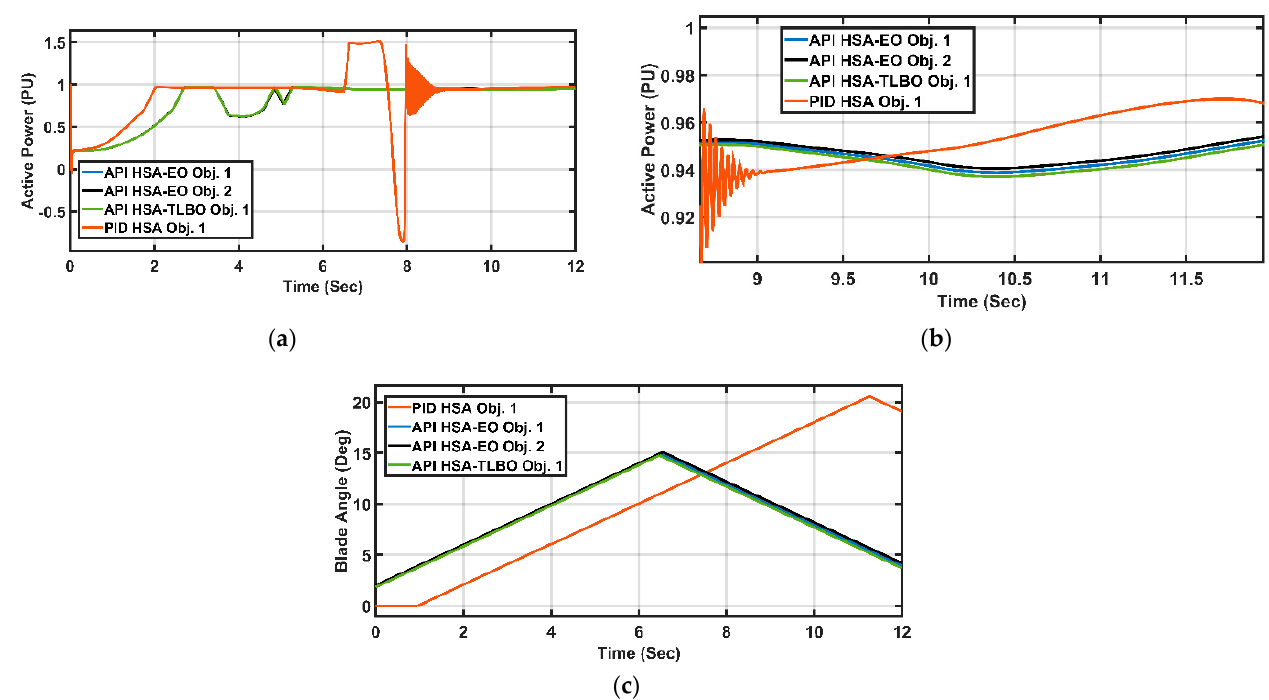
Figure 11. Wind-speed profile of normal first case.